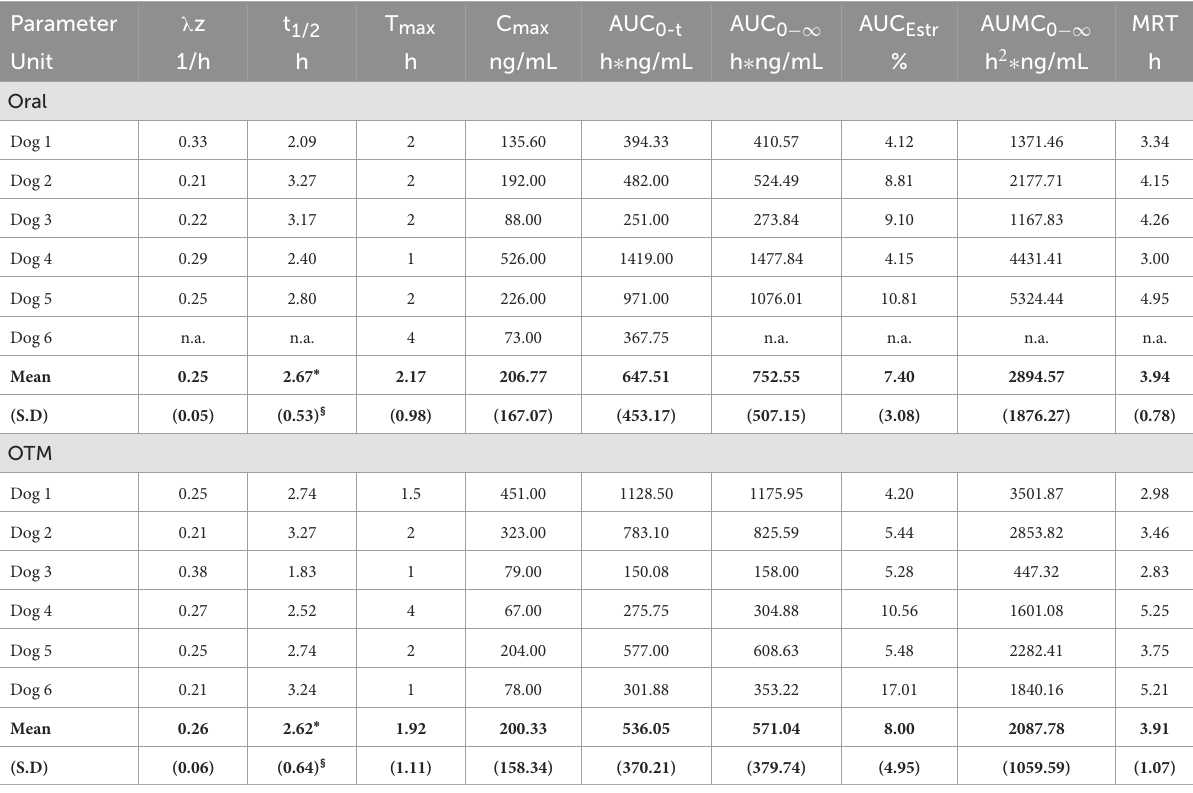
TABLE 2 Main pharmacokinetic parameters obtained following oral and OTM administration of CBD at 1 mg/kg in dogs (6 dogs/group).